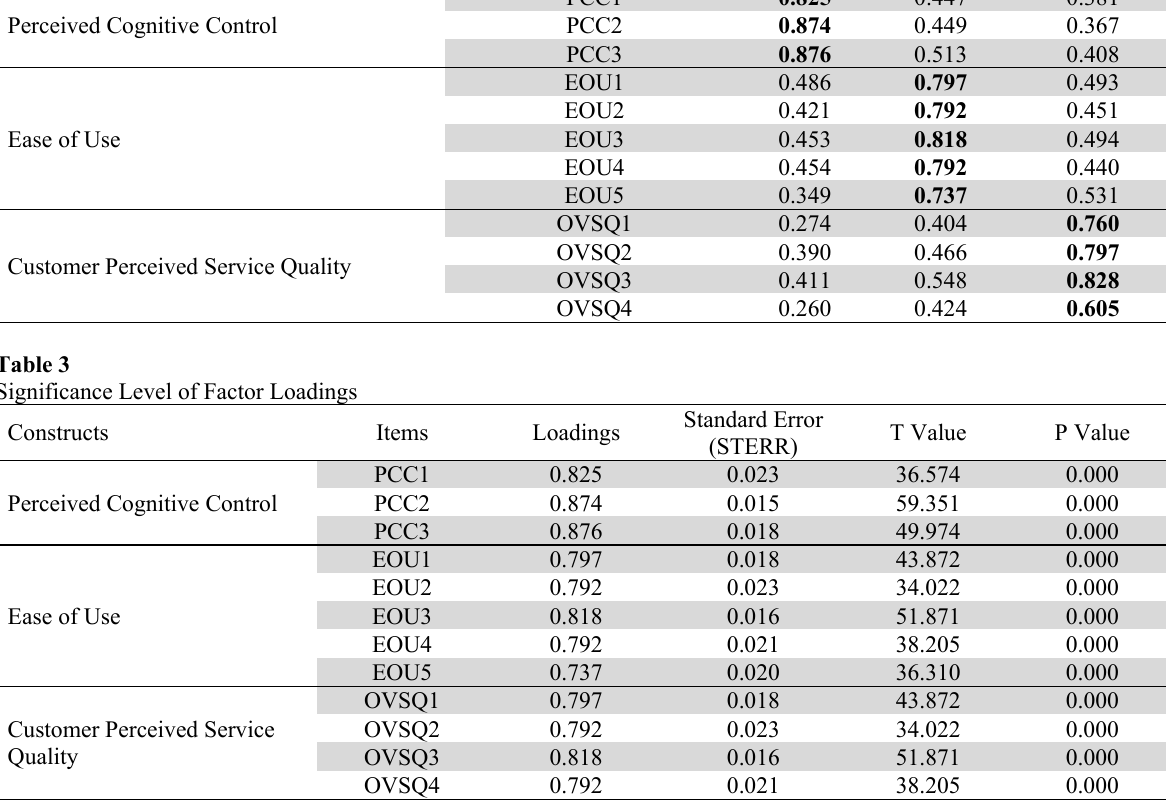
Cross Loadings of the Items Constructs Perceived Cognitive Control